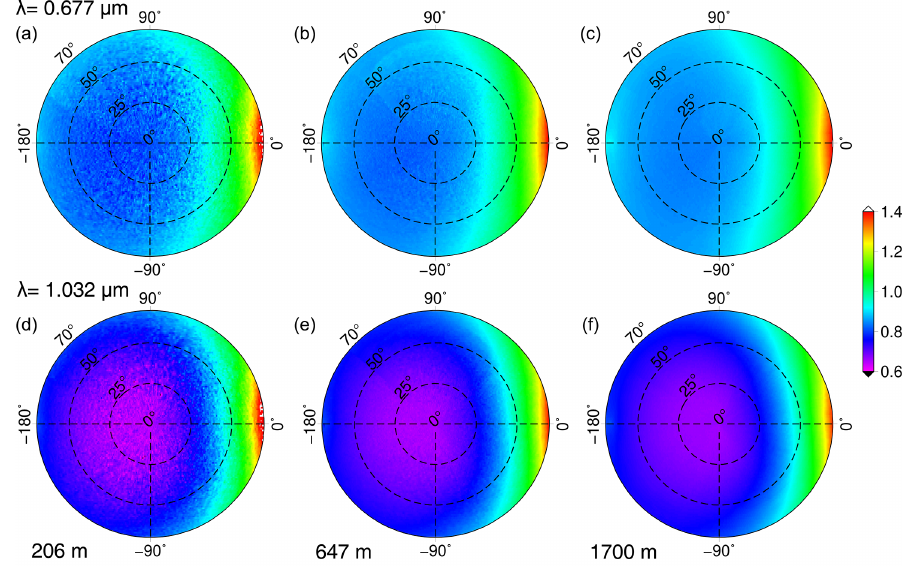
Figure 2. Angular distribution of reflectance factor in the snow–atmosphere system derived from CAR measurements on 7 April 2008 at Elson Lagoon (71.3 ◦ N, 156.4 ◦ W), showing reflectance at the 0.677µm wavelength and three flight altitudes of 206, 647, and 1700m, respectively (a, b, c) , and the 1.032µm wavelength and the same flight altitudes (d, e, f) . The principal plane is the horizontal line ( ϕ = 0 and 180 ◦ ), and the viewing zenith angle is shown as the radius of the polar plots from 0 ◦ (nadir) to 70 ◦ . The solar zenith angle is 70.23, 69.11, and 67.78 ◦ for flight altitudes of 206, 647, and 1700m, respectively.